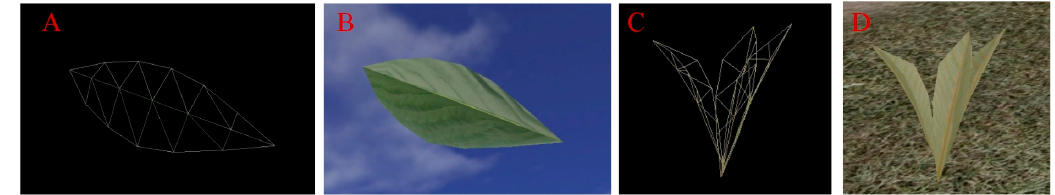
Figure 1. Screenshot of the Muluo loquat leaf model. ( A ) A leaf blade wireframe model; ( B ) A leaf blade solid model; ( C ) A cluster leaf wireframe model; ( D ) A cluster leaf solid model.